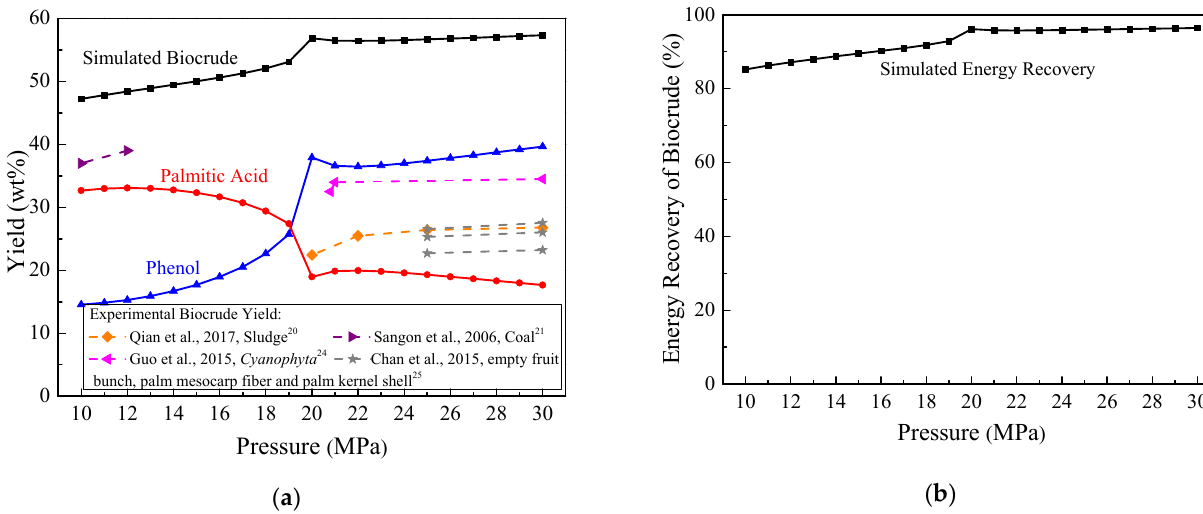
Figure 3. Effect of pressure on: ( a ) biocrude yield; ( b ) energy recovery at 350 °C and with 80 wt% moisture content.